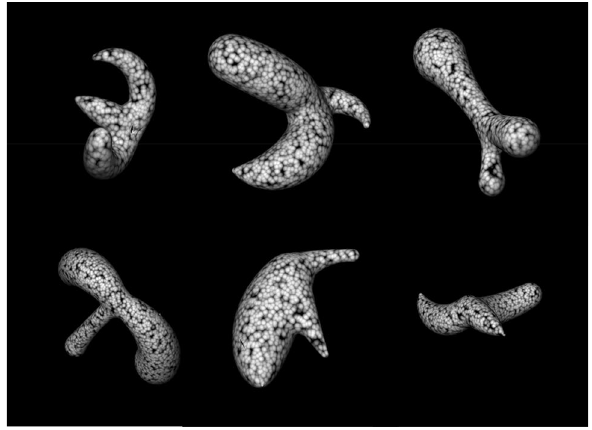
Figure 7. Illustration of a subset of the stimuli used in the novel object recognition task. The figure shows one instance of each object of the set. In the experiment, each object could be shown from one of four different